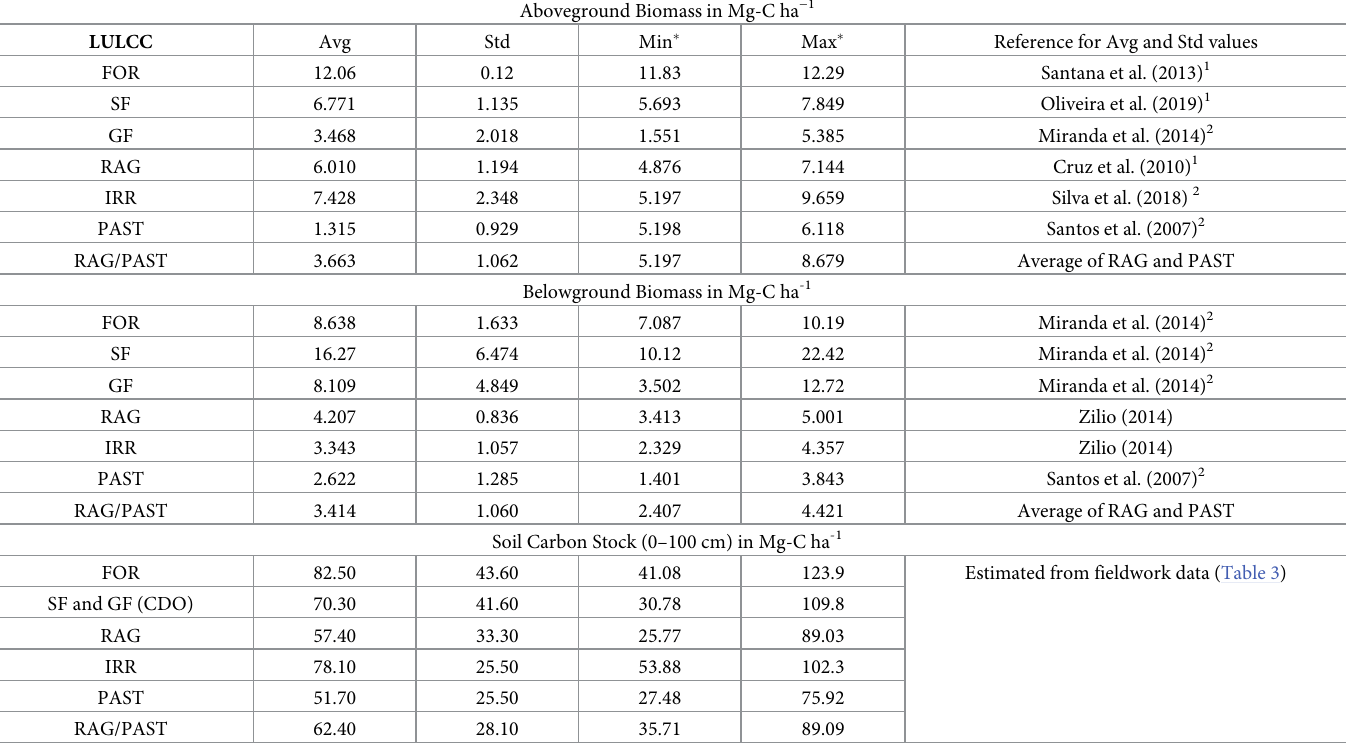
Table 2. Parameters for Land Use and Land Cover Classes (LULCCs) used in spatial reconstruction of historical carbon stocks: Forest formations (FOR), savanna formations (SF), Grassland Formations (GF), cropland or pastureland (RAG/PAST), rainfed cropland (RAG), irrigated cropland (IRR), and pastureland